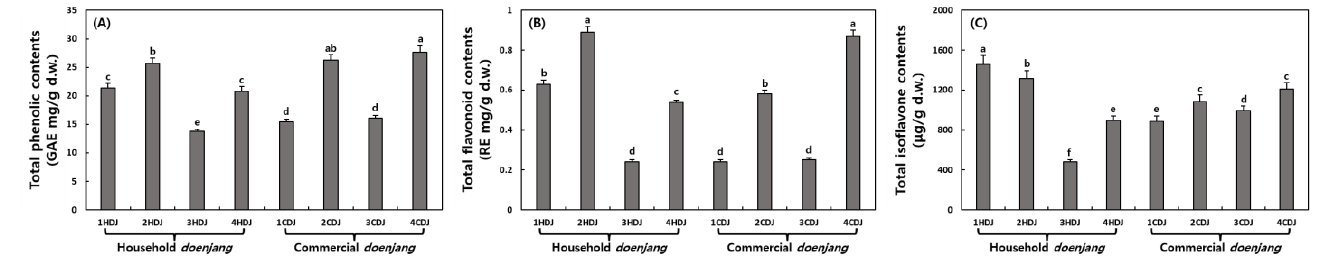
Figure 3. Comparison of total phenolic ( A ), total flavonoid ( B ), and total isoflavone ( C ) contents on household and commercial doenjang. Different letters above the bars indicate significant difference at p < 0.05 ( n = 3). Table 3. Comparison of glycoside, malonylglycoside, acetylglycoside, and aglycone isoflavone con- tents on household and commercial doenjang.